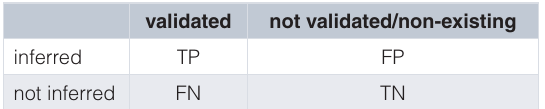
Table 2. Confusion matrix, comparing inferred network to network of validated interactions.